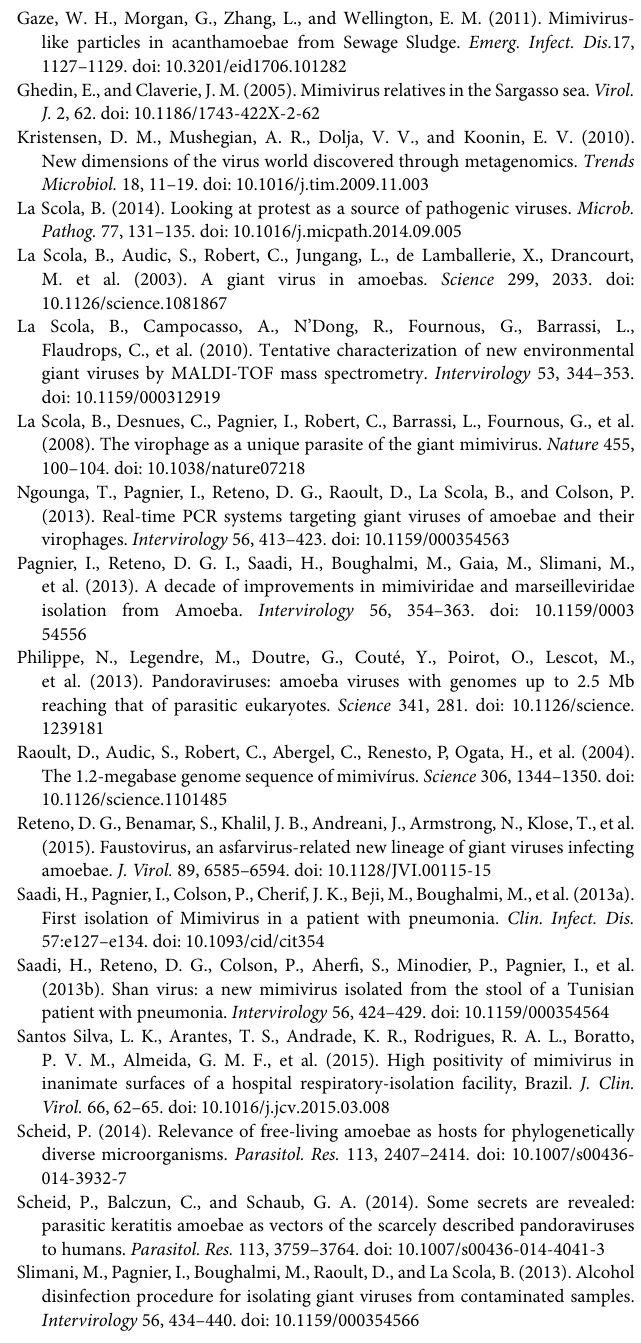
Cytospin, fixation and labeling fluorescence were done after 18 h post infection. Viral factory were showed in the images. Original magnification × 1000. (A) Negative control A. polyphaga ; (B) AP BZ 88; (C) AP BZ 87; (D) AP BZ 71. FIGURE S3 | Negative staining of the Brazilian giant viruses isolate. Supernatant of the sample were used18 h post infection. (A) AC BZ 01 Marseillevirus; (B) AC BZ 28 Mimivirus; (C) Virophage particles found in AC BZ 28; (D) AP BZ 16 Mimivirus; (E) AC BZ 81 Pandoravirus; (F) AP BZ 87